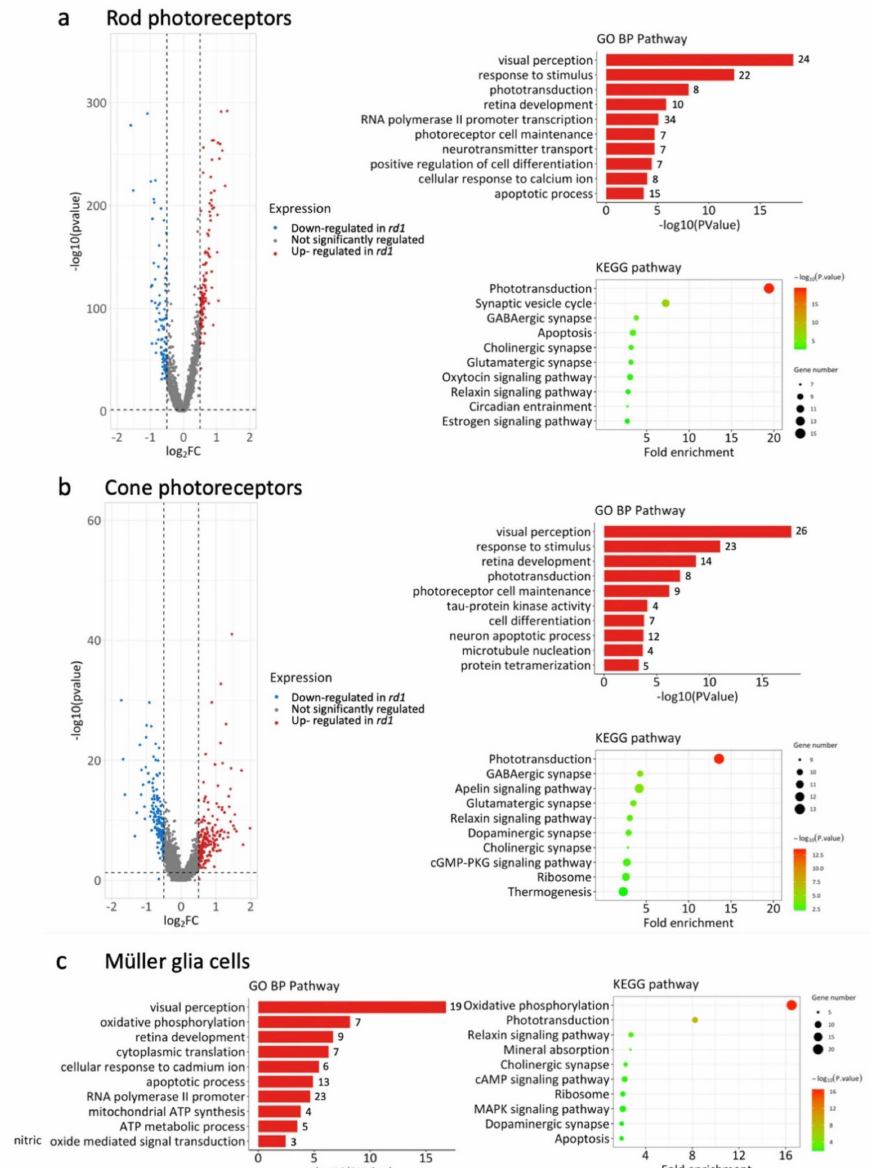
Figure 4. Network and pathway analysis for rods, cones, and Müller glia cells. Data showing differ- entially enriched genes (DEGs) in rd1 retinal cell types, compared to wild-type (WT). ( a ) Network and pathways changes in rod photoreceptors at post-natal day (P)13, i.e., at the peak of rod degeneration. Left panel: Volcano plot of all genes significantly regulated in rd1 rods (|avg_log 2 FC| > 0.58). Blue dots for downregulated genes, red dots for upregulated genes, grey indicates no significant change between rd1 and WT. Top right: Gene ontology (GO) biological category (BP) analysis of DEGs show- ing top 10 most enriched GO BP terms. The number of DEGs for each GO term are indicated on the right. Bottom right: KEGG pathway analysis of DEGs showing top 10 enriched terms. ( b ) Network and pathways changes in cone photoreceptors at P17, i.e., at the start of cone degeneration. Left panel: Volcano plot of all genes significantly regulated in rd1 cones. Blue dots for down-regulated genes, red dots for upregulated genes, grey indicates no significant change between rd1 and WT. Top right: Gene ontology (GO) biological category (BP) analysis of DEGs showing top 10 most enriched GO BP terms. The number of DEGs for each GO term are indicated on the right. Bottom right: KEGG pathway analysis showing top 10 enriched terms. ( c ) Pathways analysis on Müller cells at P13. Left: Top 10 enriched pathways in gene ontology biological process analysis. Right: KEGG pathway analysis showing top 10 enriched